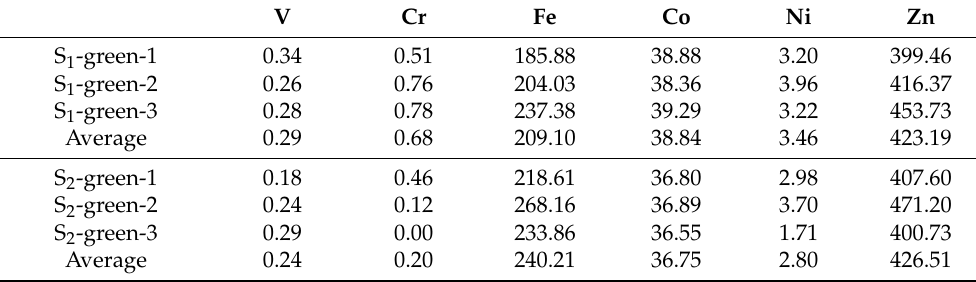
Table 2. Trace element content of three Lvwen stone specimens (all values in